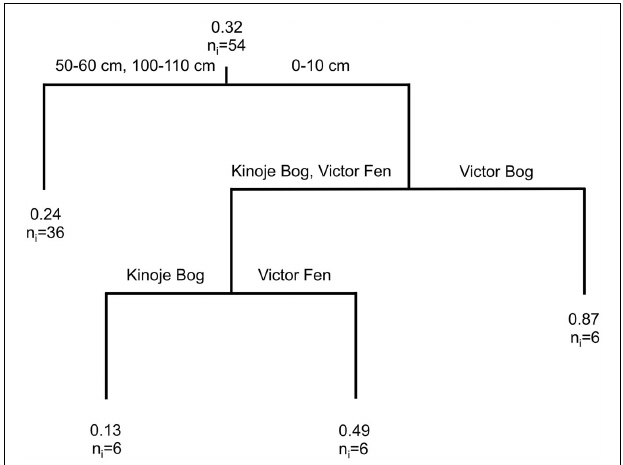
FIGURE 5 | Classification and regression tree (CART) analysis to describe the effect of temperature and aeration (anoxic and oxic) on